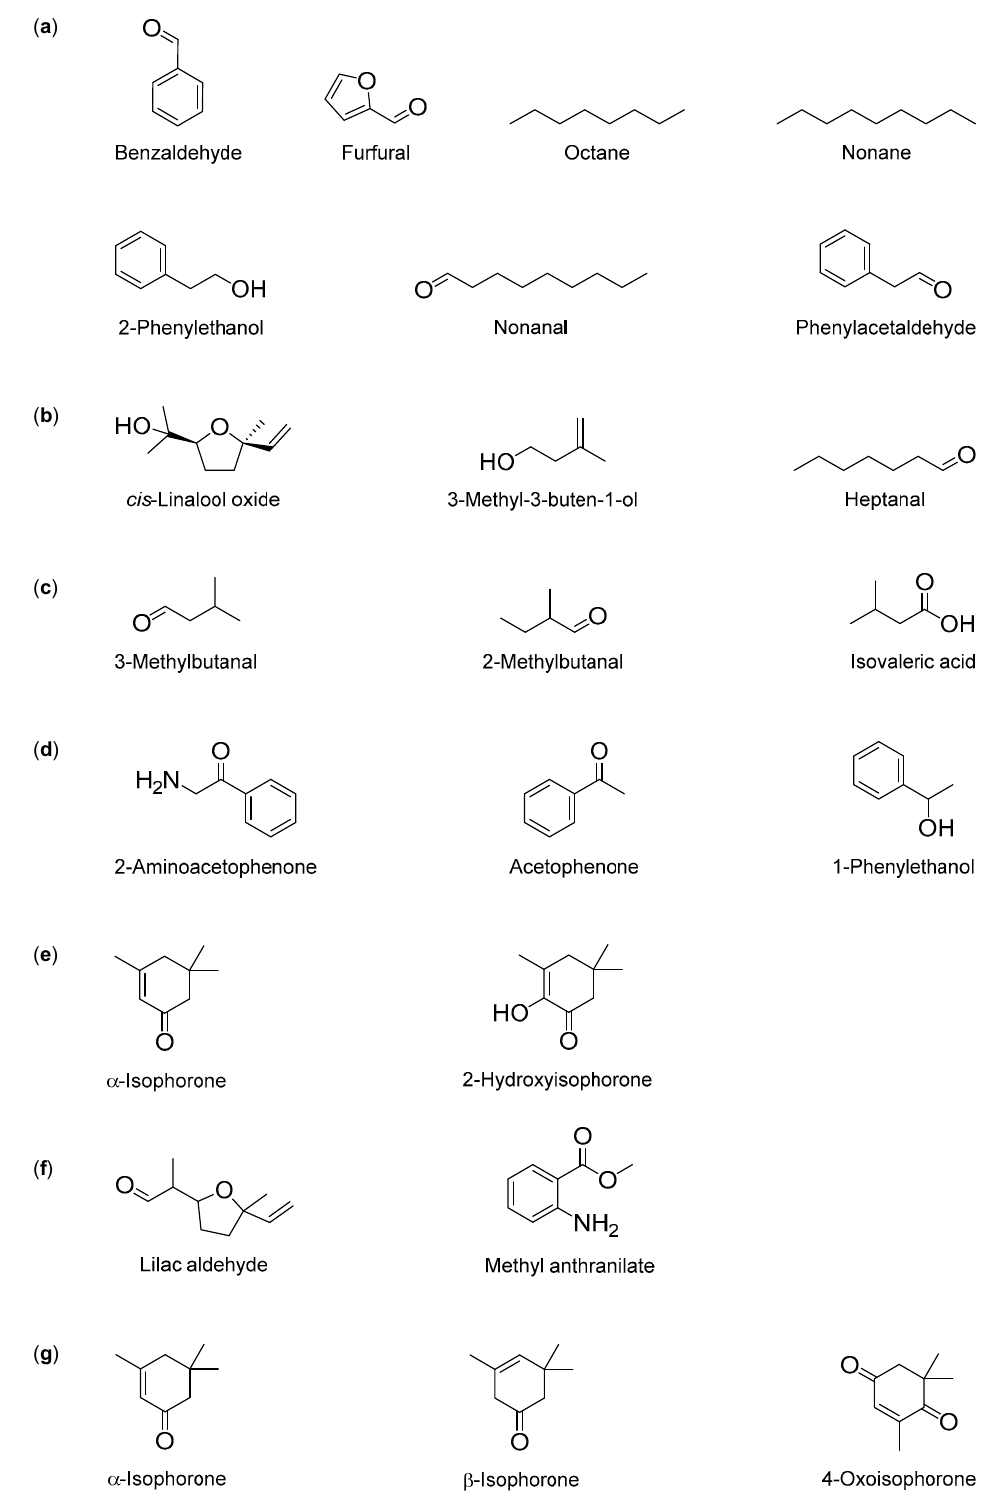
Figure 1. Chemical structures of volatile compounds identified in monofloral honeys: ( a ) Common volatile compounds to different types of monofloral honeys; Putative volatile marker compounds for ( b ) acacia honey, ( c ) buckwheat honey, ( d ) chestnut honey, ( e ) heather honey, ( f ) orange honey and ( g ) strawberry tree honey.